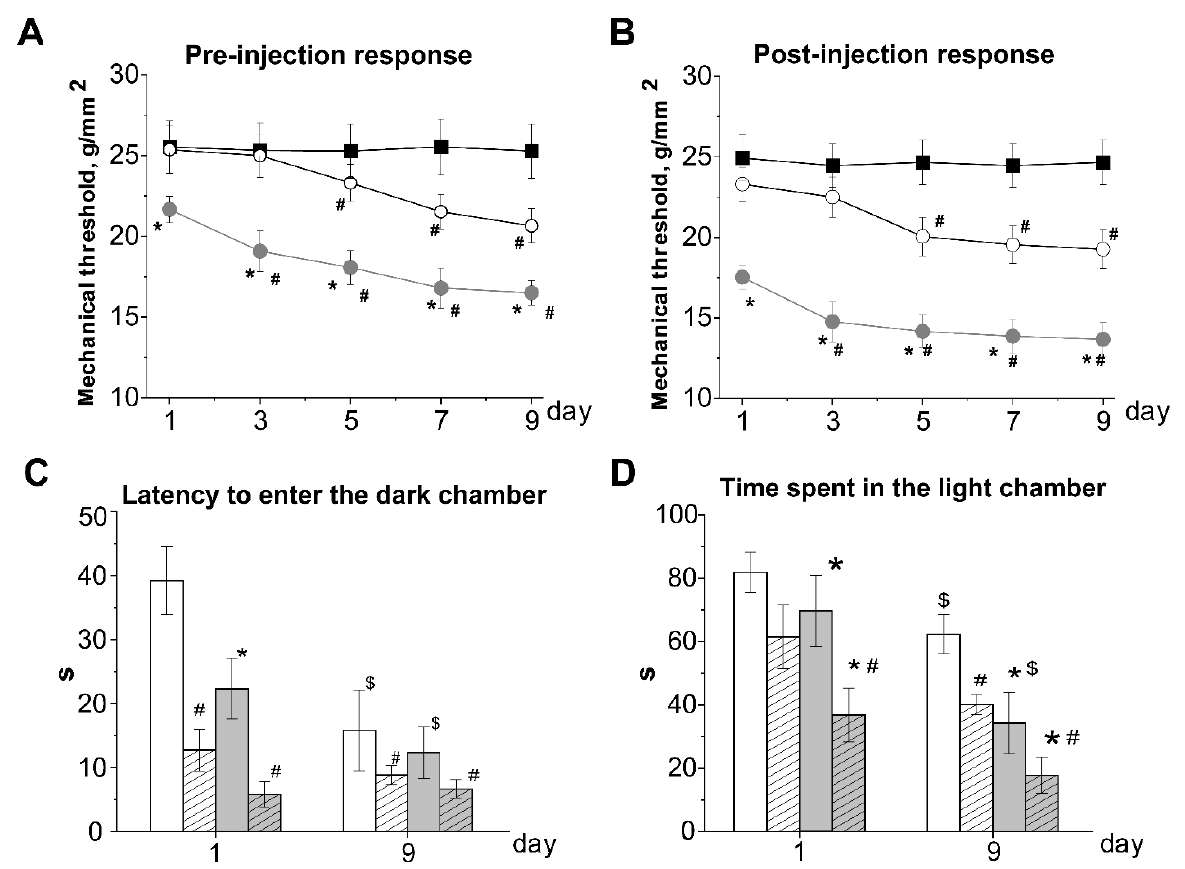
Figure 2. Effects of chronic nitroglycerine (NTG) administration on mechanical hyperalgesia and behavior in the light-dark transition test. Mechanical withdrawal thresholds of rats from the control (open circle), hHCY groups (grey circle) and vehicle (black square) groups before ( A ), basal response) and two hours after ( B ), post-injection response) chronic NTG administration. * p < 0.05 compared to the control group, # p < 0.05 compared to the initial values. Latency to enter the dark chamber ( C ) and time the rats spent in the light chamber ( D ) before (open columns) and two hours after (dashed columns) NTG administration at the first and 9th day of experimentation; control (white column) and hHCY (grey dashed column) groups, * p < 0.05 compared to the control group, # p < 0.05 compared to the pre-injection level, $ p < 0.05 compared to values of the first day.